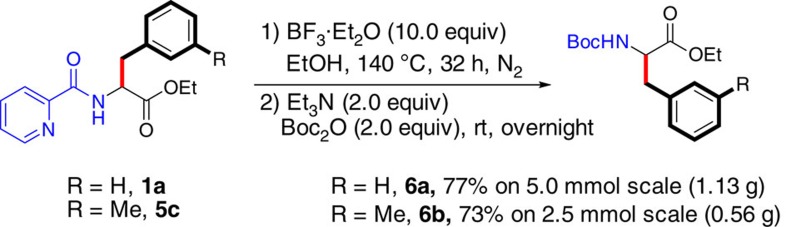
Removal of the coordinating group.Deprotection of the picolinamido group by treatment with BF3·Et2O.